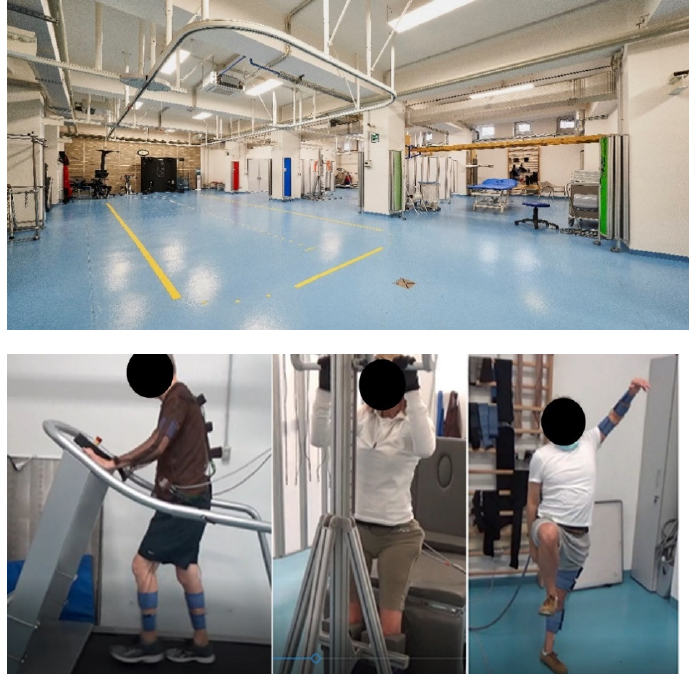
Figure 3. Employed set-ups for training at the VIKTOR Physio LAB.